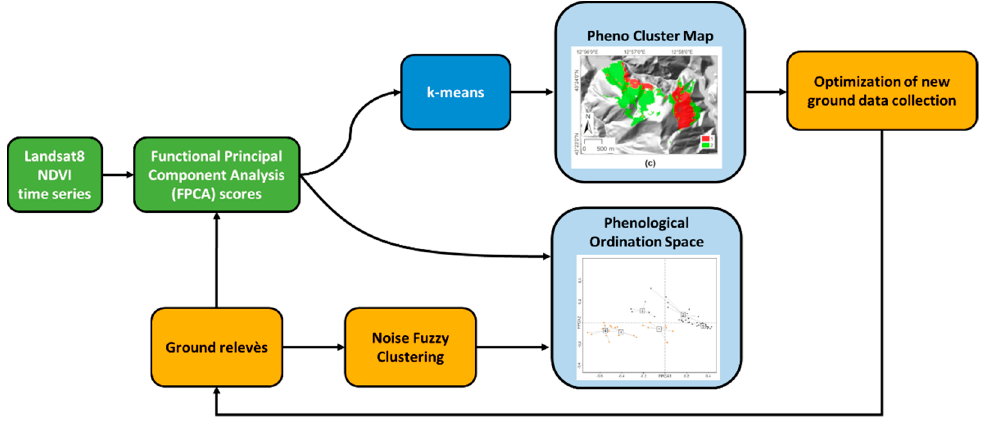
Figure 1. Graphical representation of methodology. Starting from normalized difference vegetation index (NDVI) time series, we used functional principal component analysis (FPCA) to relate NDVI dynamics with plant communities.